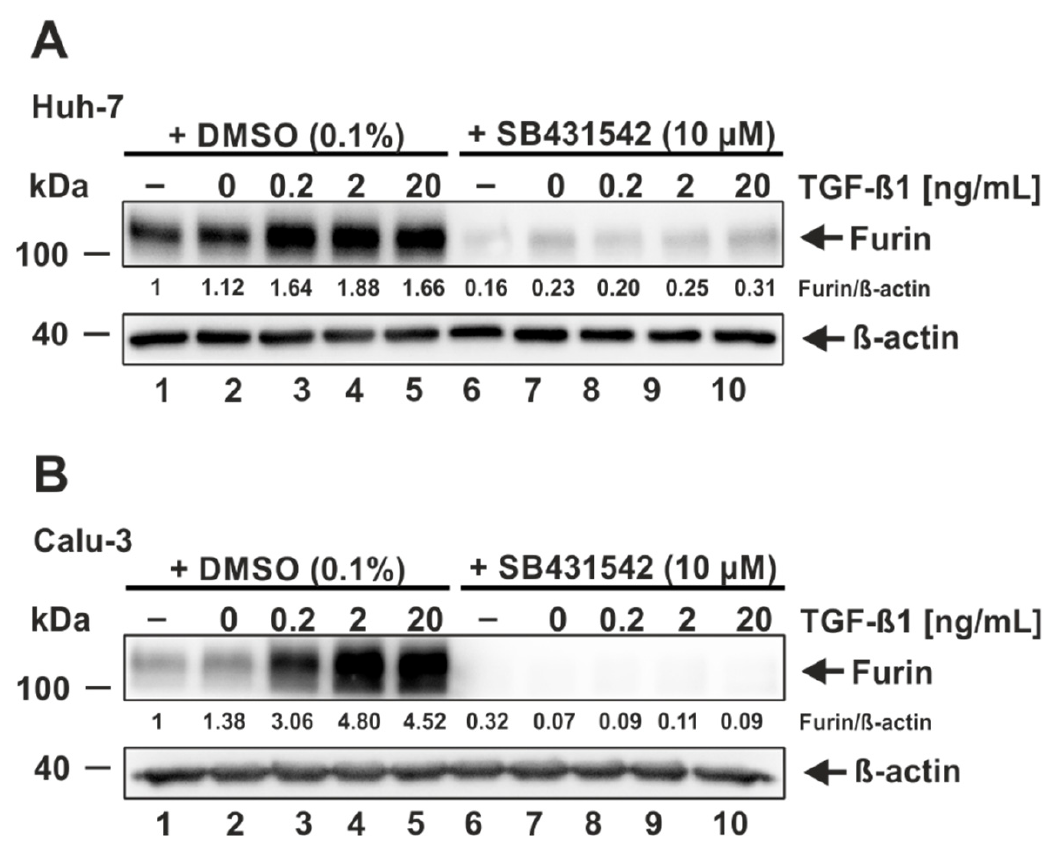
Figure 4. Prevention of TGF-ß1-induced furin expression by the ALK5 inhibitor SB431542. ( A ) Huh-7 and ( B ) Calu-3 were incubated for 24 h with 10 µM SB431542 or the solvent control DMSO and